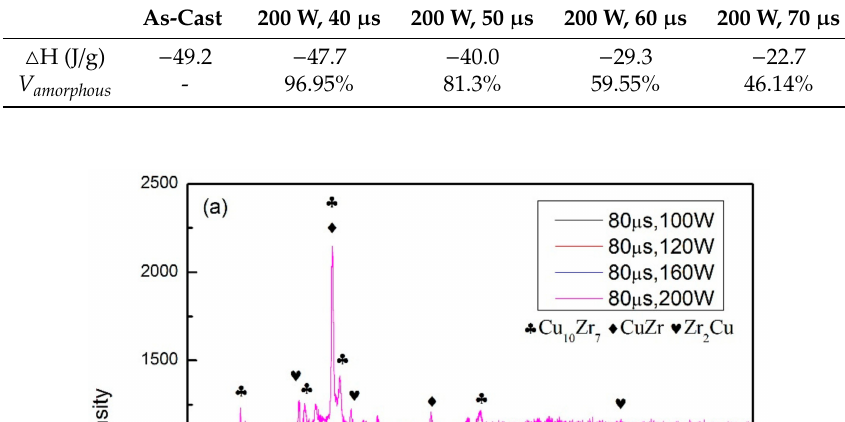
Table 3. Crystallization enthalpy and volume fraction of the amorphous phase of as-cast and SLM specimens with parameters of P = 200 W, t = 40, 50, 60, and 70 µ